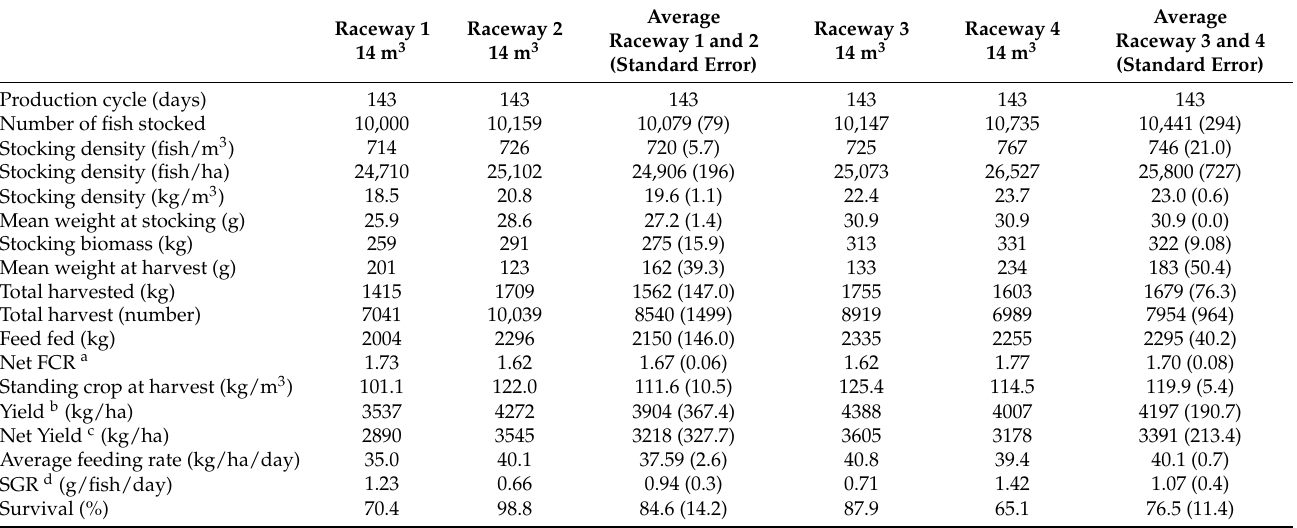
Table 5. Stocker growth performance of hybrid catfish (channel catfish Ictalurus punctatus catfish, I. furcatus ) raised in the in-pond raceway system (IPRS) “stocker unit” raceways placed in ♂ 0.4 ha ponds,